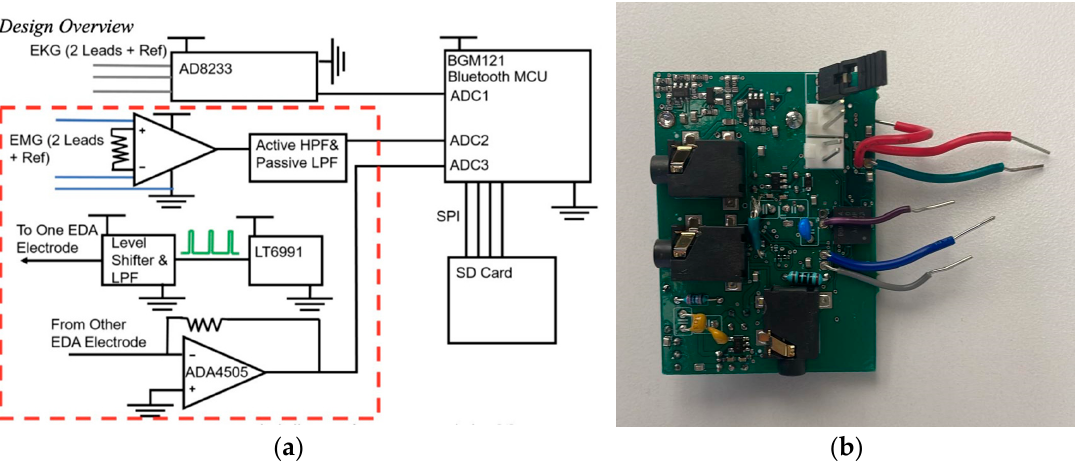
Figure 1. ( a ) Circuit design and ( b ) Constructed prototype chip.